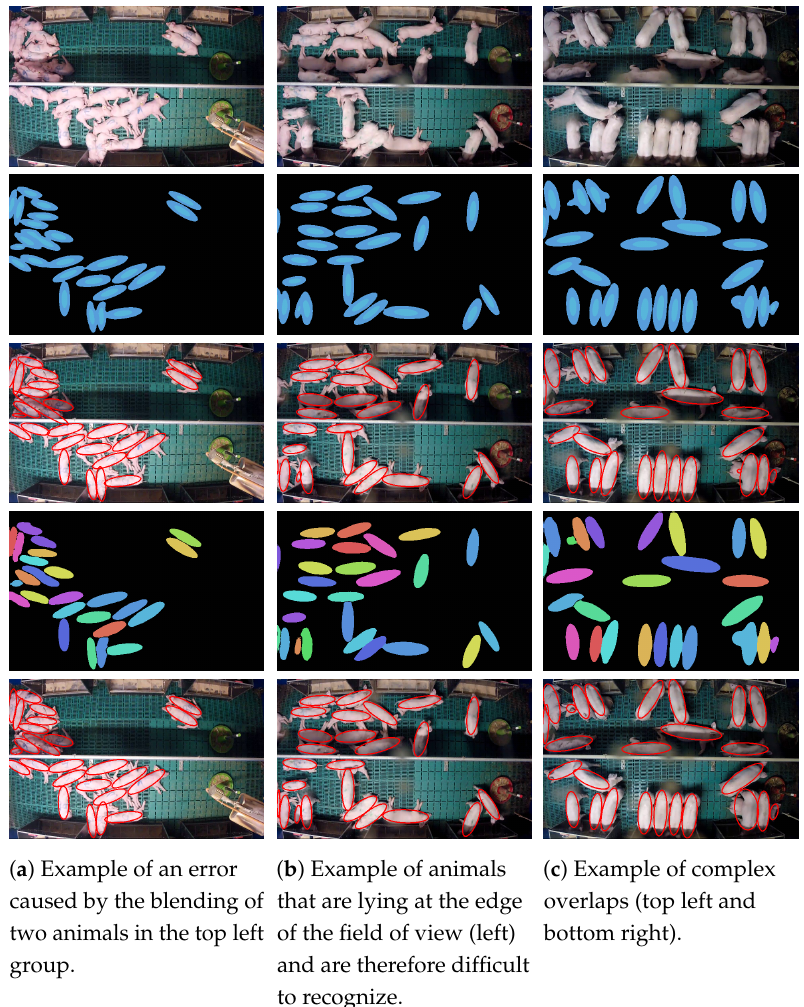
Figure 11. Examples of the difficulties that the data set contains: The pictures show from top to bottom the original image, the prediction of the categorical segmentation, the ellipses extracted from the categorical segmentation, the prediction of the combined segmentation, and the ellipses extracted from the combined